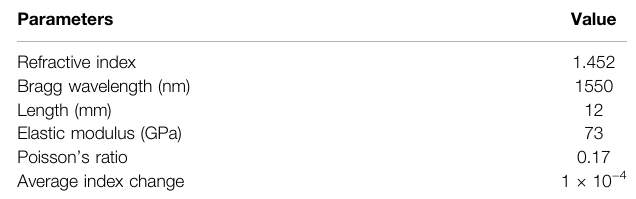
TABLE 1 | Parameters of the